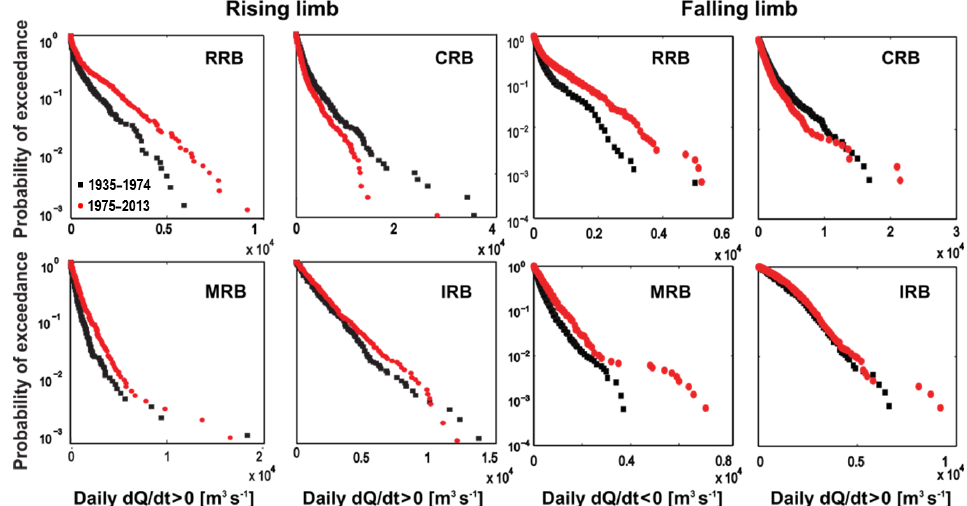
Figure 9. Daily streamflow change exceedance probabilities, where daily d Q/ d t > 0 characterizes rising limb flows and daily d Q/ d t < 0 characterizes falling limb flows. Study basin acronyms are defined as follows: Red River of the North basin (RRB), Minnesota River basin (MRB), Chippewa River basin (CRB), and Illinois River basin (IRB).